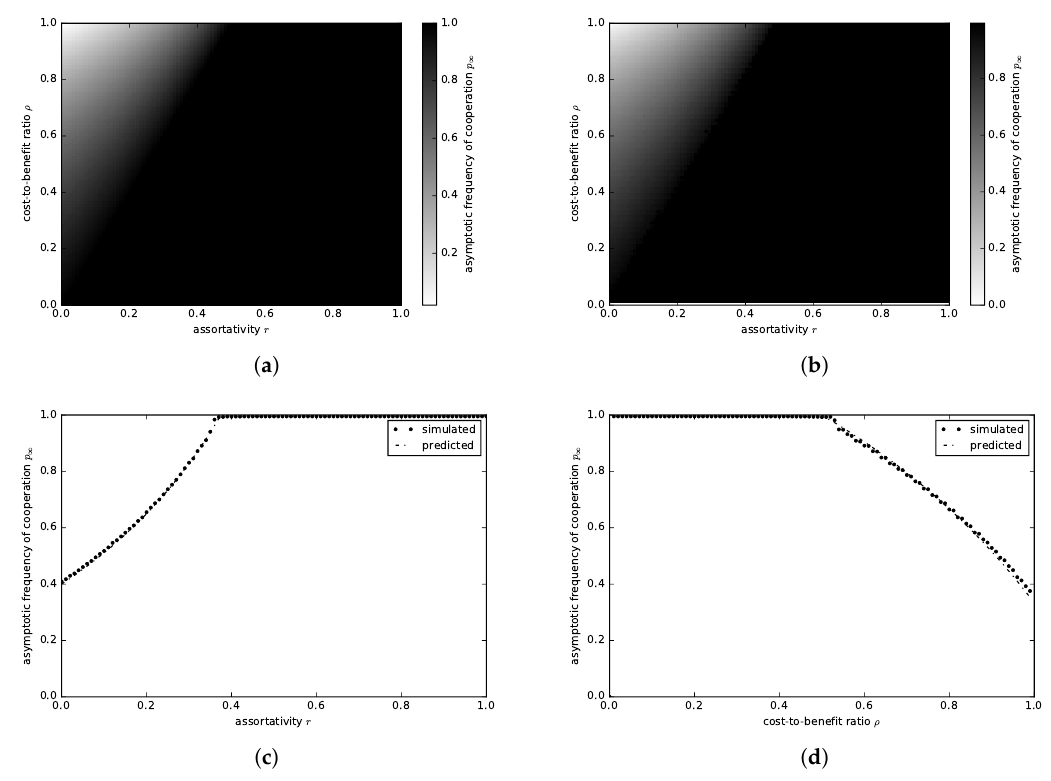
Figure 5. Variation of the long-term frequency p ∞ of cooperators with assortativity r ∈ [ 0,1 ] and cost-to-benefit ratio ρ ∈ ( 0,1 ) for the snowdrift game. ( a ) p ∞ (analytically predicted) versus r and ρ . ( b ) p ∞ (simulated) versus r and ρ . ( c ) p ∞ versus r when ρ = 0.75. ( d ) p ∞ versus ρ when r = 0.25. Parameters: n = 10,000, p 0 = 0.5, and β =